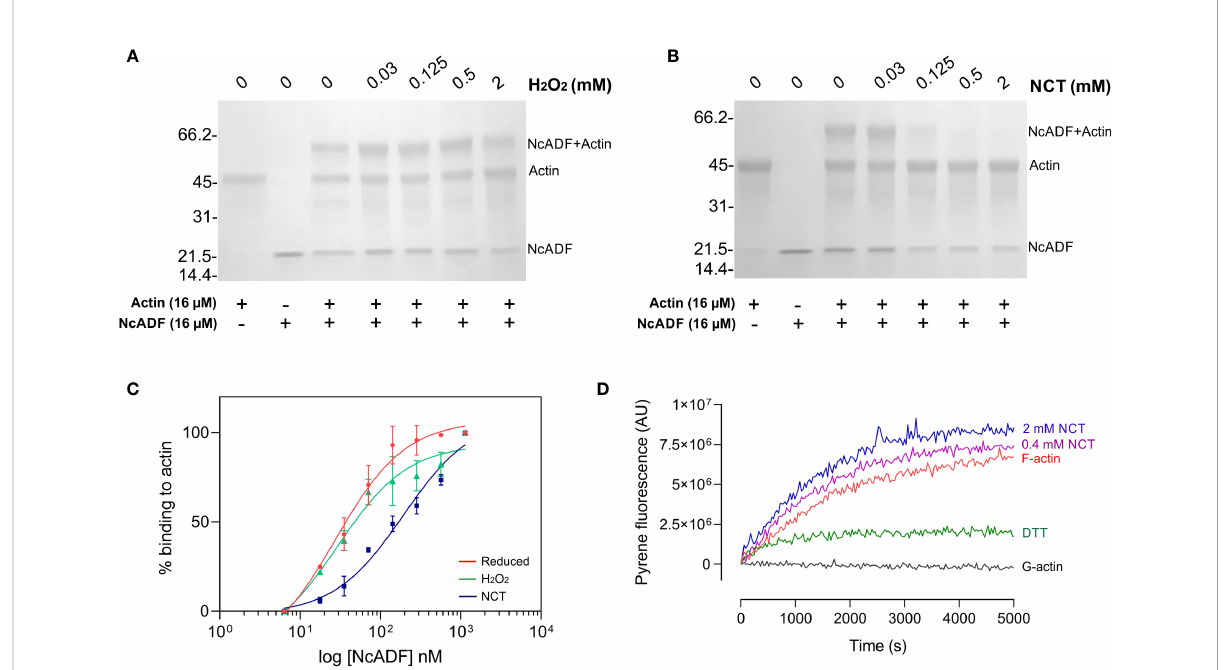
FIGURE 3 Binding and dynamic of oxidized NcADF and actin. Previously reduced NcADF was incubated with H 2 O 2 or NCT and the binding with actin was assessed. (A, B) NcADF (16 µM) was treated with 0-2 mM H 2 O 2 (A) or NCT (B) . After inactivation with catalase (A) or histidine/methionine (B) , NcADF was incubated with 16 µM G-actin for 18 h EDC (2 mM) was added to the reaction, which was resolved by 15% SDS-PAGE and stained with Coomassie G-250. (C) G-actin (2.5 µg/ml) was immobilized and incubated with 0-20 µg/ml NcADF oxidized with either 2 mM NCT or H 2 O 2 . NcADF was detected with NcADF antiserum (1:1,000) and anti-mouse secondary antibody-HRP (1:10,000). Reduced NcADF EC50 (red circles) = 27.6 nM; NCT treated NcADF EC50 (blue squares) = 192.4 nM; H 2 O 2 treated NcADF (green triangles) = 29.5 nM. Results from two (2) experimental replicates. (D) PI-G-actin (15% PI-actin; 10 µM) was mixed with 10 µM NcADF previously treated with 0-2 mM NCT. The actin polymerization was induced and the fl uorescence was measured over time. Grey line = G-actin control without NcADF; green line = actin polymerization with reduced NcADF; red line = actin polymerization without NcADF; purple line = actin polymerization with NcADF (oxidized with 0.4 mM NCT); blue line = actin polymerization with NcADF (oxidized with 2 mM